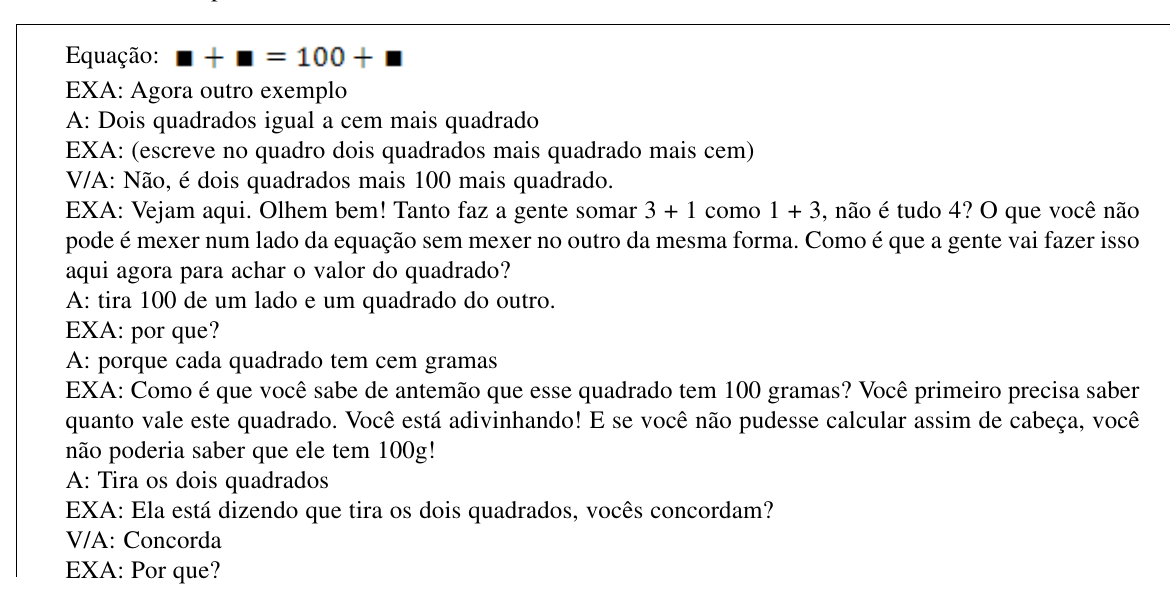
Figura 2 . Realizar operações inversas para retirar os termos dos membros da equação Mostrar que a Ordem dos Fatores Não Altera o Produto, mas a Retirada dos Fatores em Um Membro e Não em Outro, Altera a equivalência da Equação Como mostra o episódio